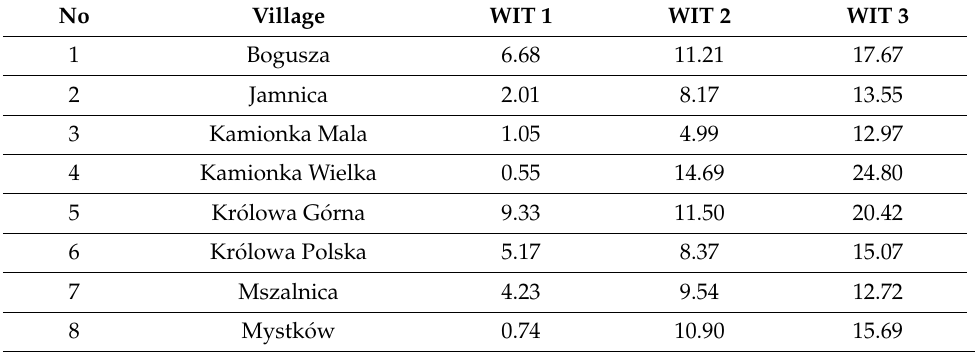
Table 2. Calculated values of WIT.